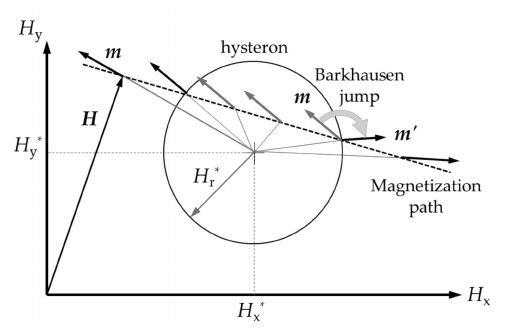
Figure 1. Hysteron effect on the magnetization state given a magnetization path: the hysteron is centered in ( H x *, H y *), and it has radius H r *.